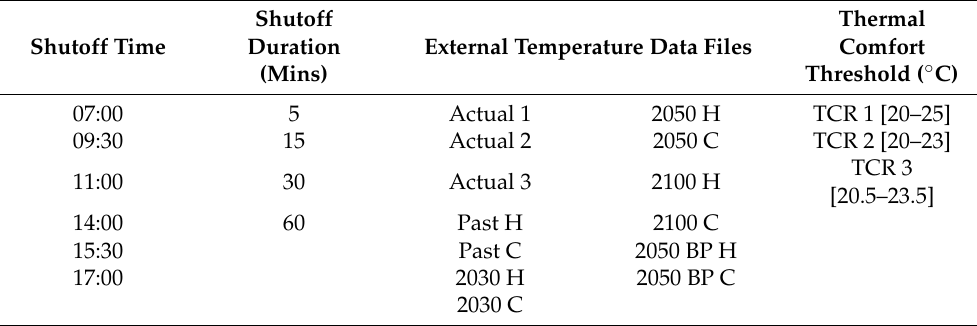
Table 4. Shutoff times, durations, external temperature files and thermal comfort thresholds used as modelling scenario